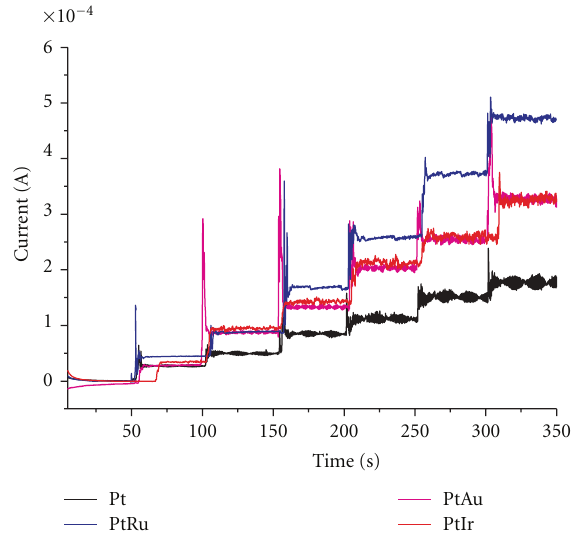
Figure 5: Typical amperometric response of di ff erent metals to di ff erent concentrations of H 2 O 2 (0.25 mM, 0.5mM, 0.75 mM, 1.25mM, 2.25 mM, and 3.25 mM).